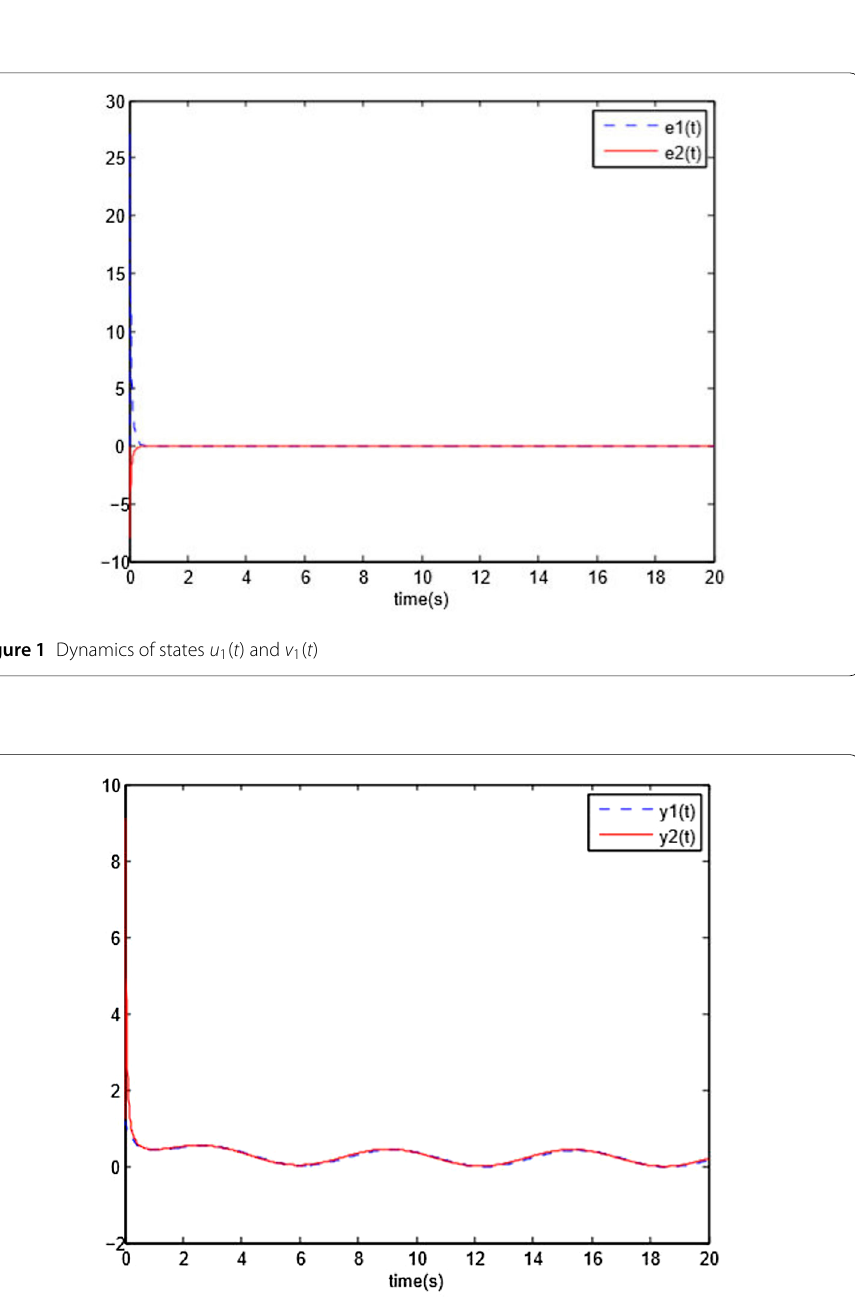
Figure 2 Dynamics of states u 2 ( t ) and v 2 ( t